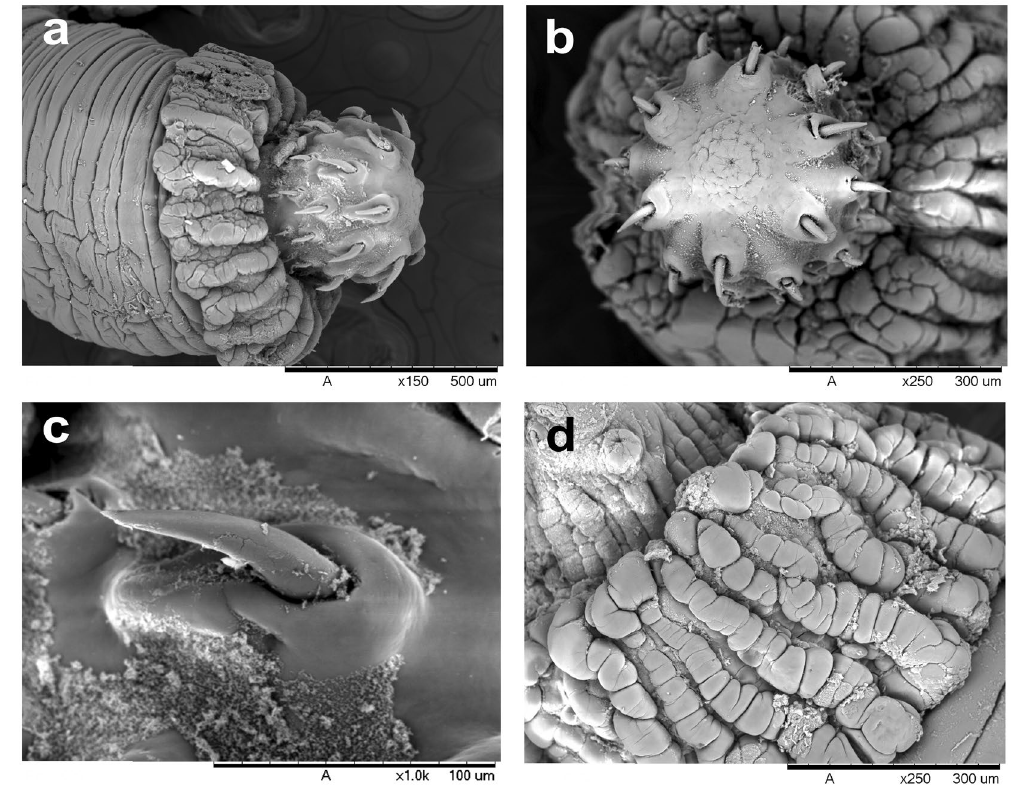
Figure 2. Scanning electron microscopy observations of P. elegans adults collected from S. o. citrinellus . ( a ) Side view of an adult showing five hook rows in the anterior portion of the body followed by a characteristic collar of the species (Bar: 500 µm). ( b ) Top view of the anterior portion of P elegans body. Six hooks per row can be observed (Bar: 300 µm). ( c ) Magnification of a hook (Bar: 100 µm). ( d ) Ribbon characteristic of P elegans observed after the protrusible anterior end.